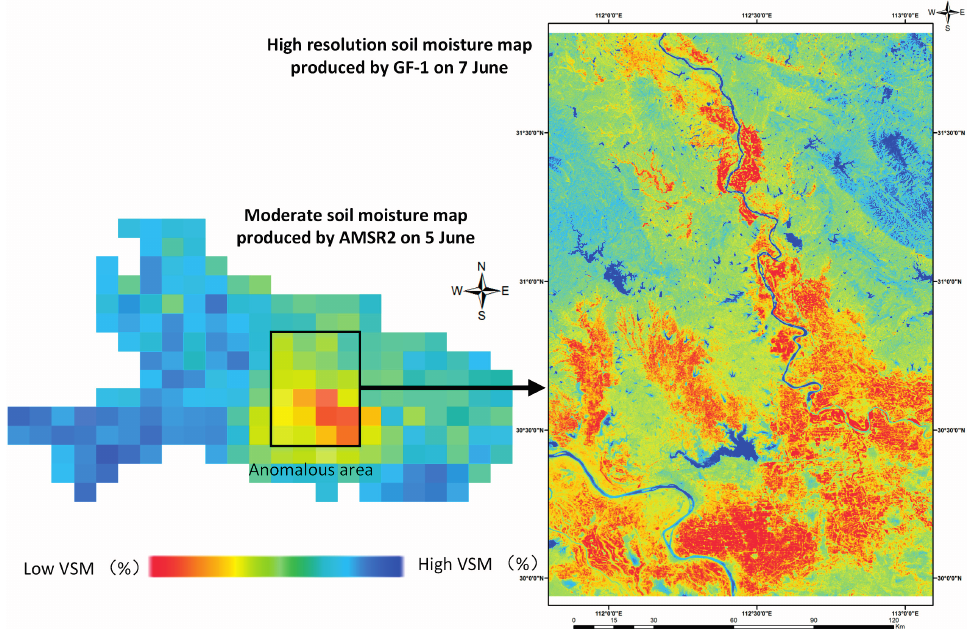
Figure 12. The moderate- and high-resolution soil maps were obtained by using the STMC method on 5 June and 7